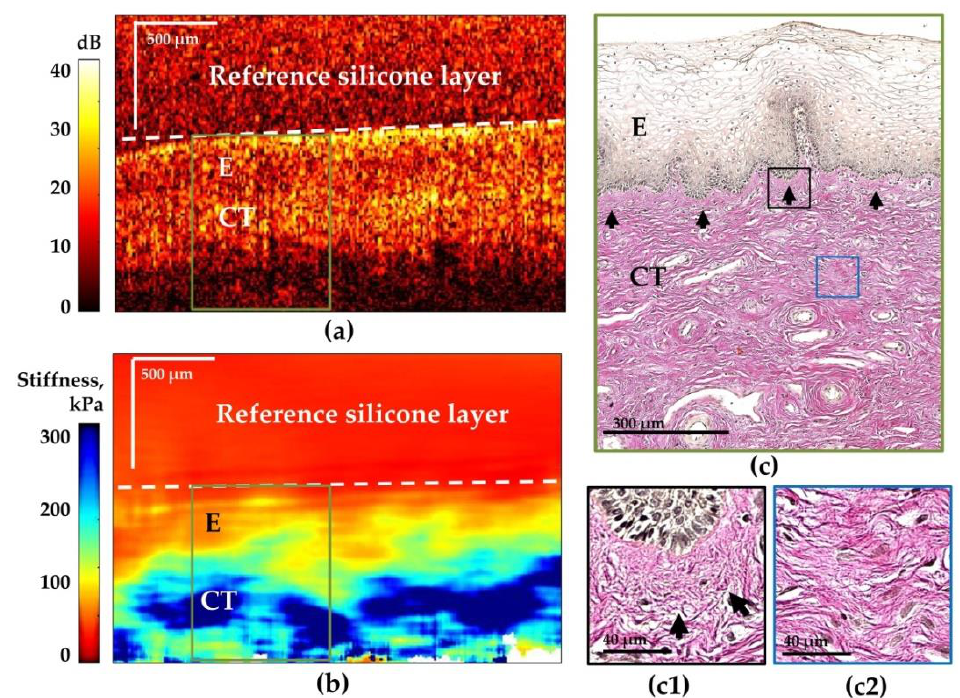
Figure 2. Representative depth-wise structural OCT ( a ) and C-OCE ( b ) images of age norm vagi- nal wall with the corresponding histology ( c – c2 ). The right column ( c – c2 ) is the histological slide stained with Van Gieson’s, where ( c )—an overview image of a well-organized two-layer tissue archi- tecture with a sharp border between the glycogenated epithelium and the submucosal connective tissue underlying it, arrows indicate the subepithelial region of the stroma ( × 100); black square ( c1 )—subepithelial region of the submucosa, where black arrows point at very thin non-directional collagen bundles ( × 1000); and blue square ( c2 )—a deeper area of the submucosa, which is char- acterized by larger winding collagen fibers forming bundles and predominantly parallel to the epithelium, There are practically no spaces between them ( × 1000). White dotted lines on OCT ( a ) and C-OCE ( b ) images are the transition boundary between the calibration silicone layer and the tissue under study. The green box on the OCT ( a ) and C-OCE ( b ) images is the area corresponding to the histological image in ( c ). Abbreviations: E − epithelium, СТ− connective tissue.